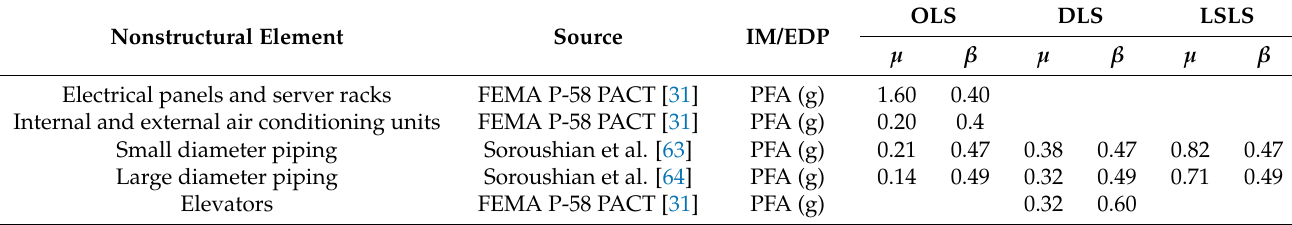
Table 9. Median µ and logarithmic standard deviation β values of the lognormal fragility curves for MEP nonstructural elements, along with the literature